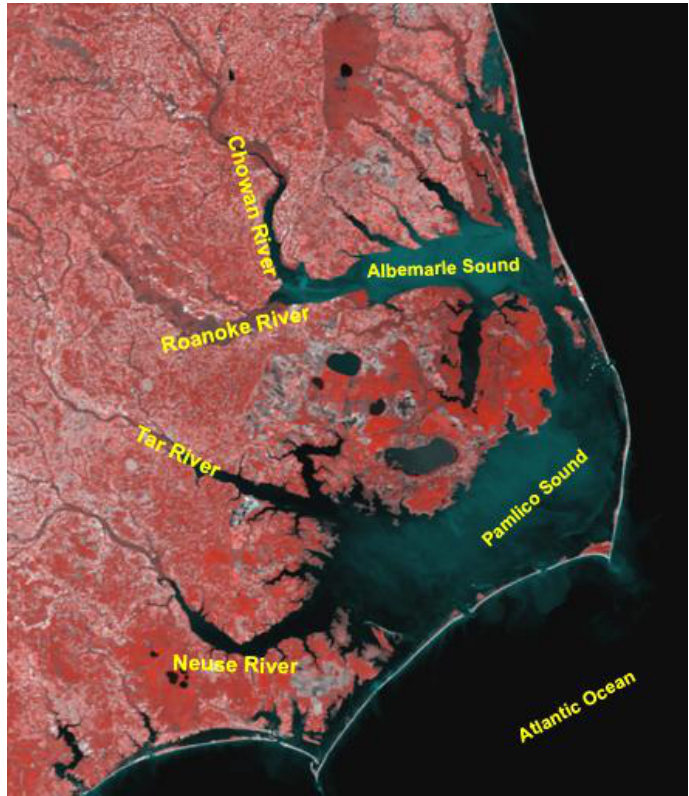
Figure 1. A MODIS 250 m false color image of the Albemarle-Pamlico Estuarine System, North Carolina showing the major rivers and